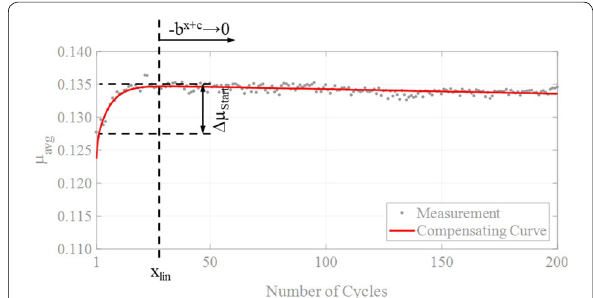
Figure 10 Sample trend plot µ avg with derived characteristic values x lin and �µ start